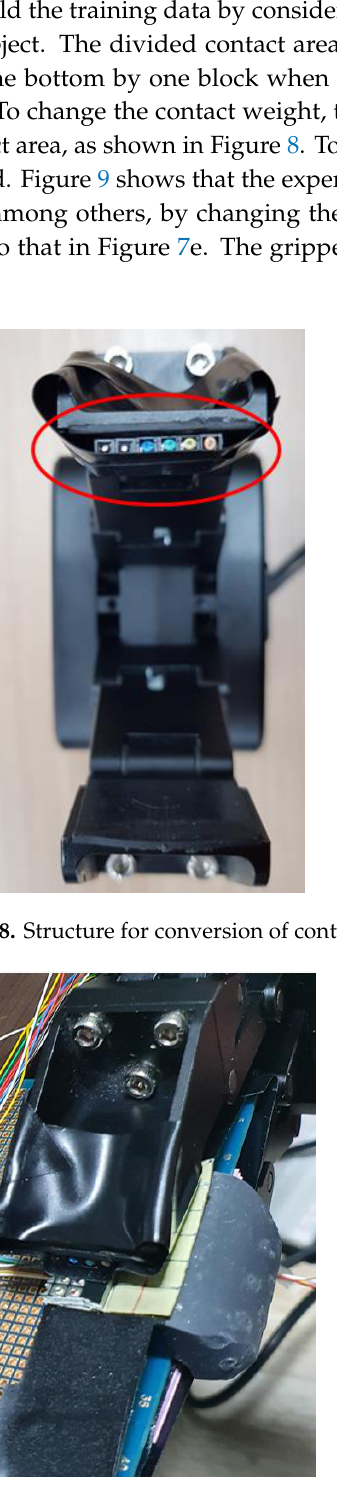
Figure 9. Experiment measured by converting contact area and force.